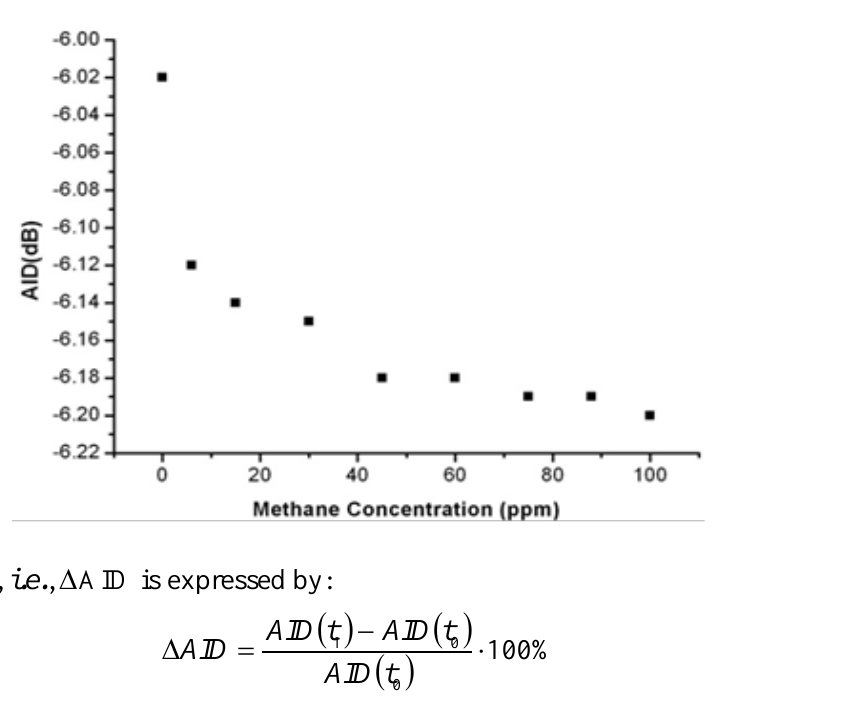
Figure 9. AID versus concentration of